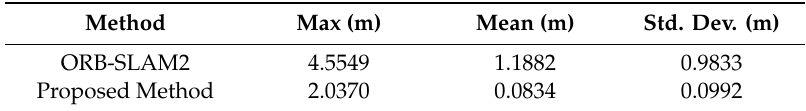
Table 3. Statistical results of matching error between sparse maps generated by the two methods and the ground truth LiDAR data.